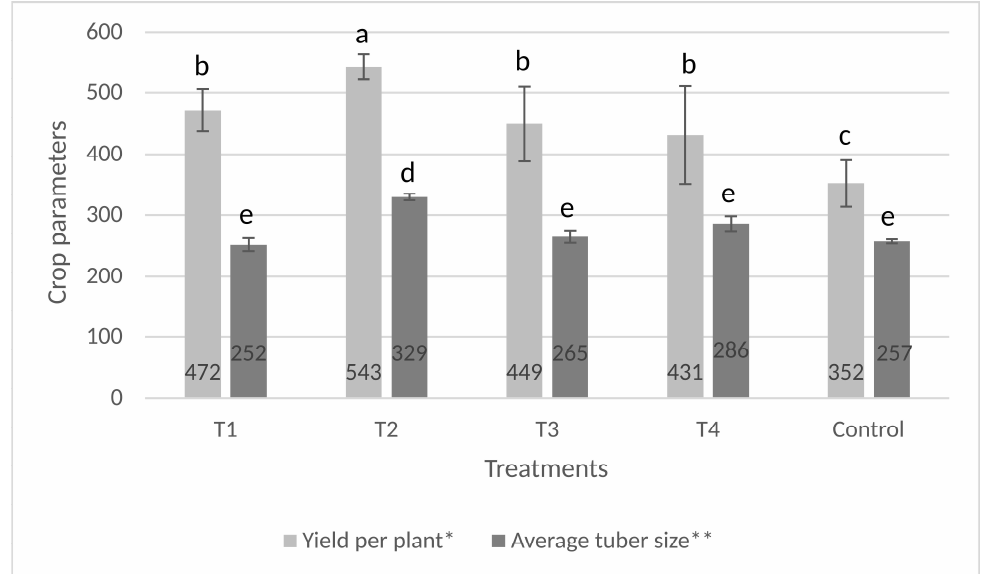
Figure 8. Effect of microbial treatment on sweet potato storage root yield and average tuber size at Szentes in 2019. The same letters above the data in the columns mean no significant difference ( p ≥ 0.05) (mean ± SD) by the LSD test * or Tukey test **. T1: soaking secondary cuttings in the mixed microbial suspension; T2: same as T1 with an additional inoculation of the soil with the mixed microbial suspension; T3: inoculation of the soil with the mixed microbial suspension near the rows before planting; T4: same as T3 with an additional inoculation of the soil with the mixed microbial suspension; C: control (no microbial treatments